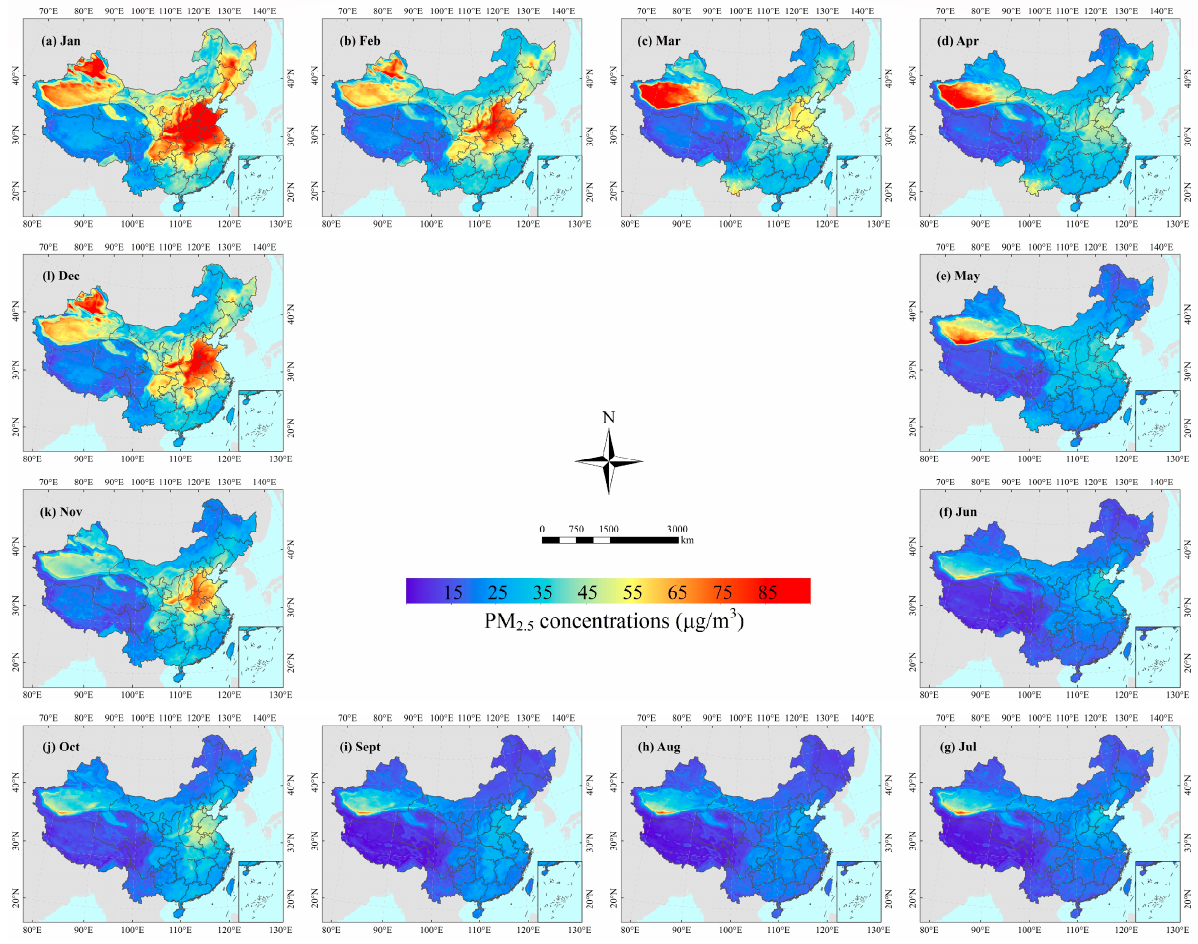
Figure 5. Multi-year averaged (2018–2020) estimated PM 2.5 concentrations for each month over the study area.